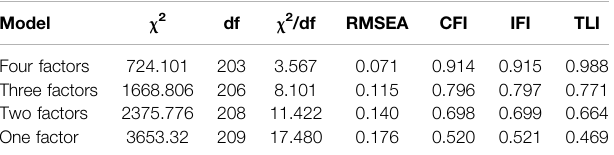
TABLE 1 | Con fi rmatory factor